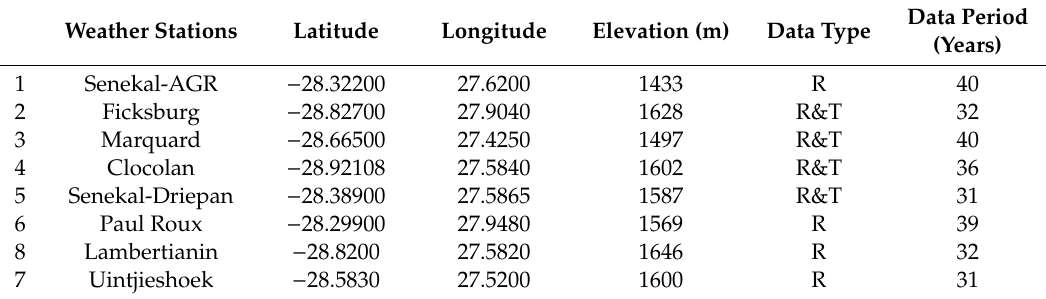
Table 1. List of weather stations used for this study with their longitudes, latitudes, elevation, duration of data availability and their data type. R denotes rainfall and T denotes both the minimum and maximum